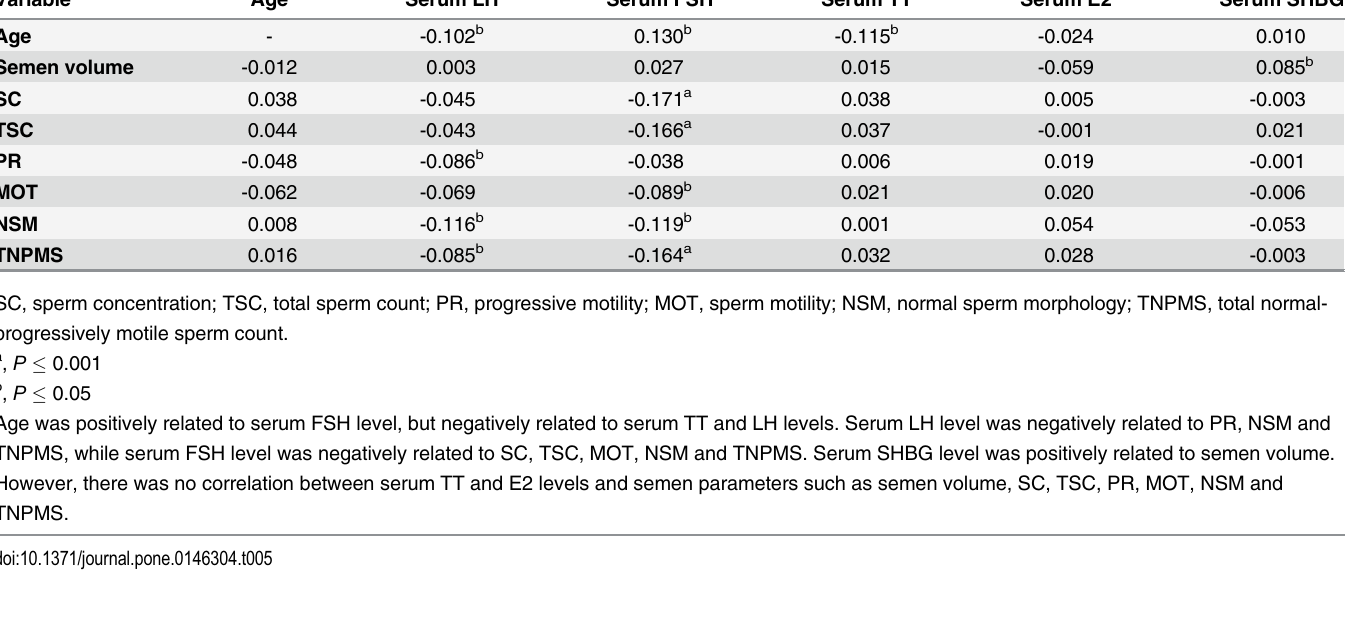
Table 5. Nonparametric (Spearman) correlation coefficients between semen parameters and age and serum reproductive hormones.